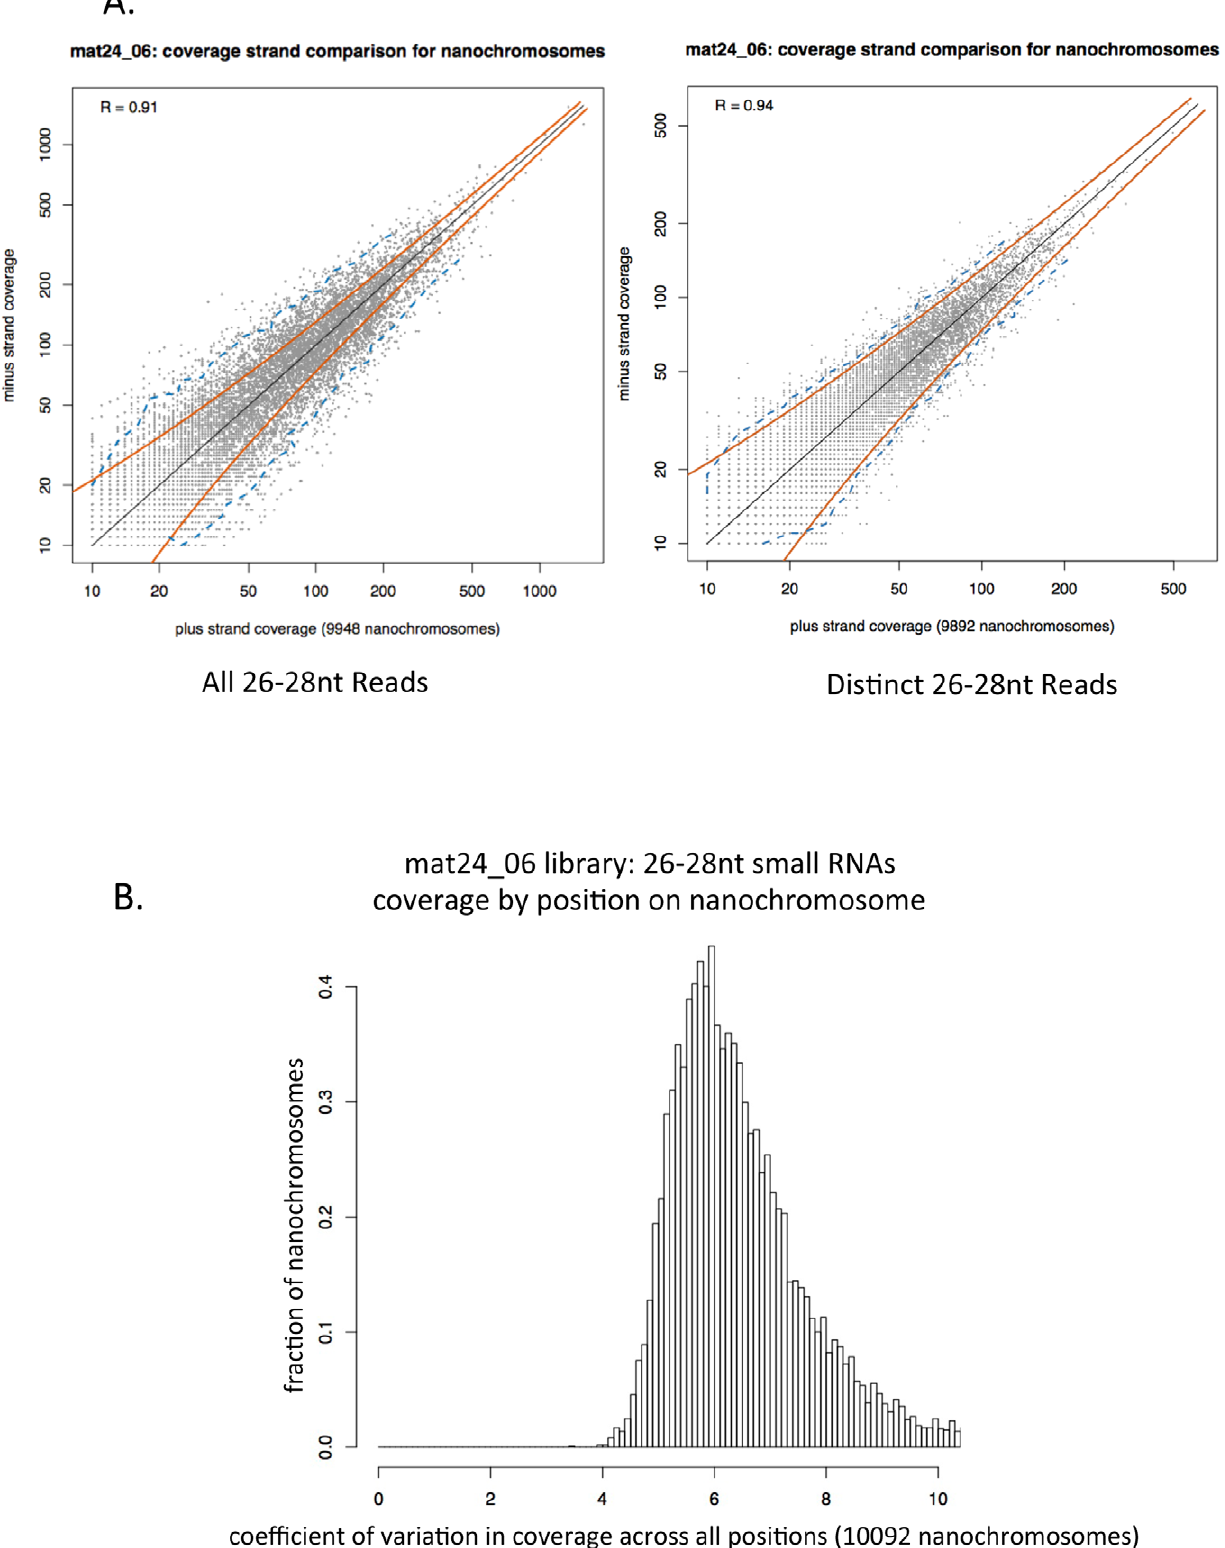
Figure 10. Analysis of the distribution of 27 nt RNAs on macronuclear nanochromosomes. A . 27 nt RNA small RNAs are produced in equal numbers from both strands of the nanochromosome. For each full length nanochromosome with at least ten 26–28 nt small RNAs aligning to each strand, the total number of 26–28 nt small RNAs that map to each strand was plotted (left graph) or the number of distinct 26–28 nt small RNAs